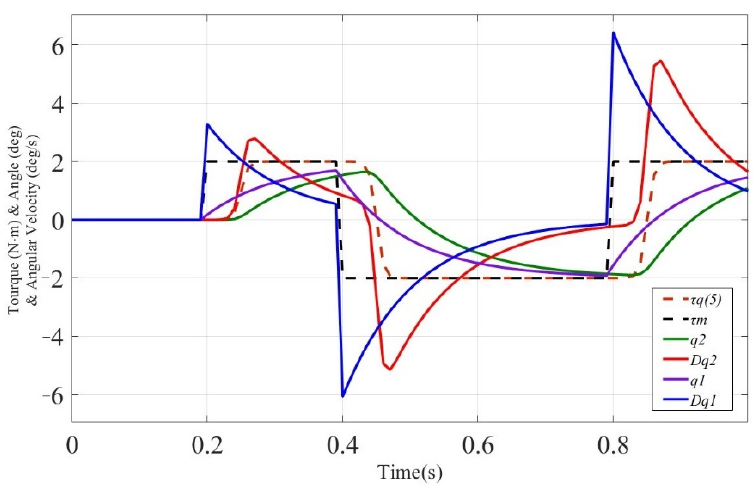
Figure 6. The angle and angular velocity rectangular wave response curves of the virtual flexible module.